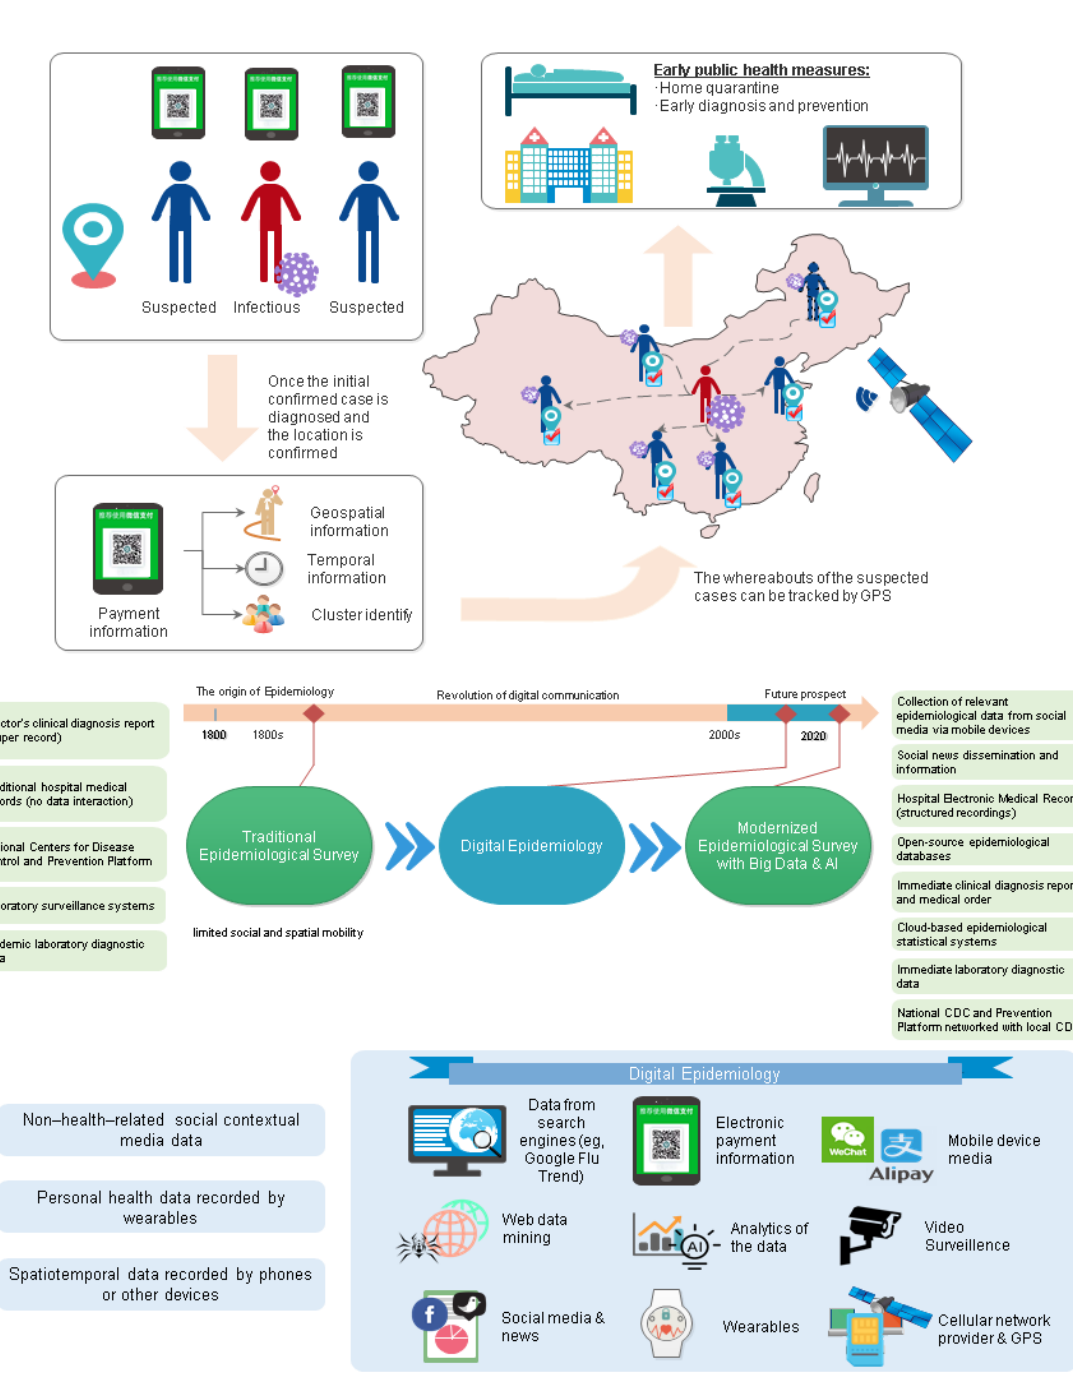
Figure 1. An infographic illustrating the development of digital epidemiology and its application in controlling infectious disease epidemics. CDC: Centers for Disease